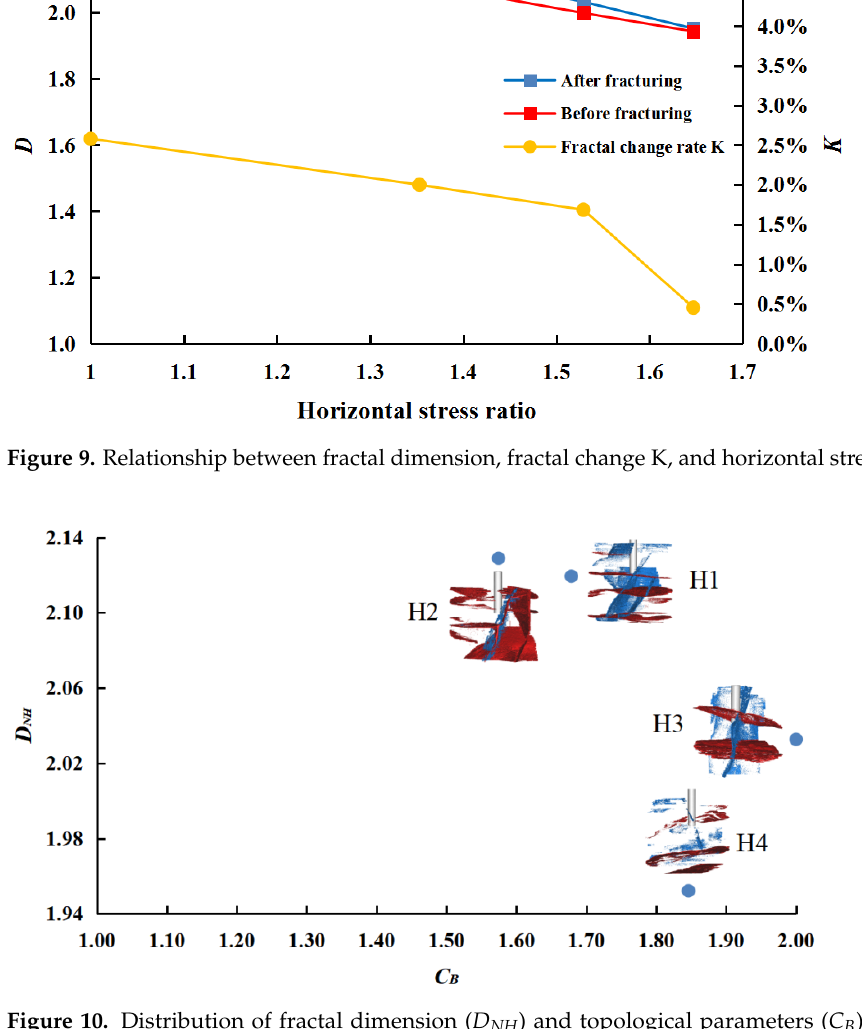
Figure 10. Distribution of fractal dimension ( D NH ) and topological parameters ( C B ) of fractures under different horizontal stress ratios.